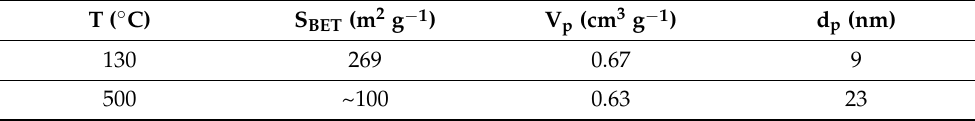
Table 1. Textural characteristics of elaborated nanotubes before and after calcination.